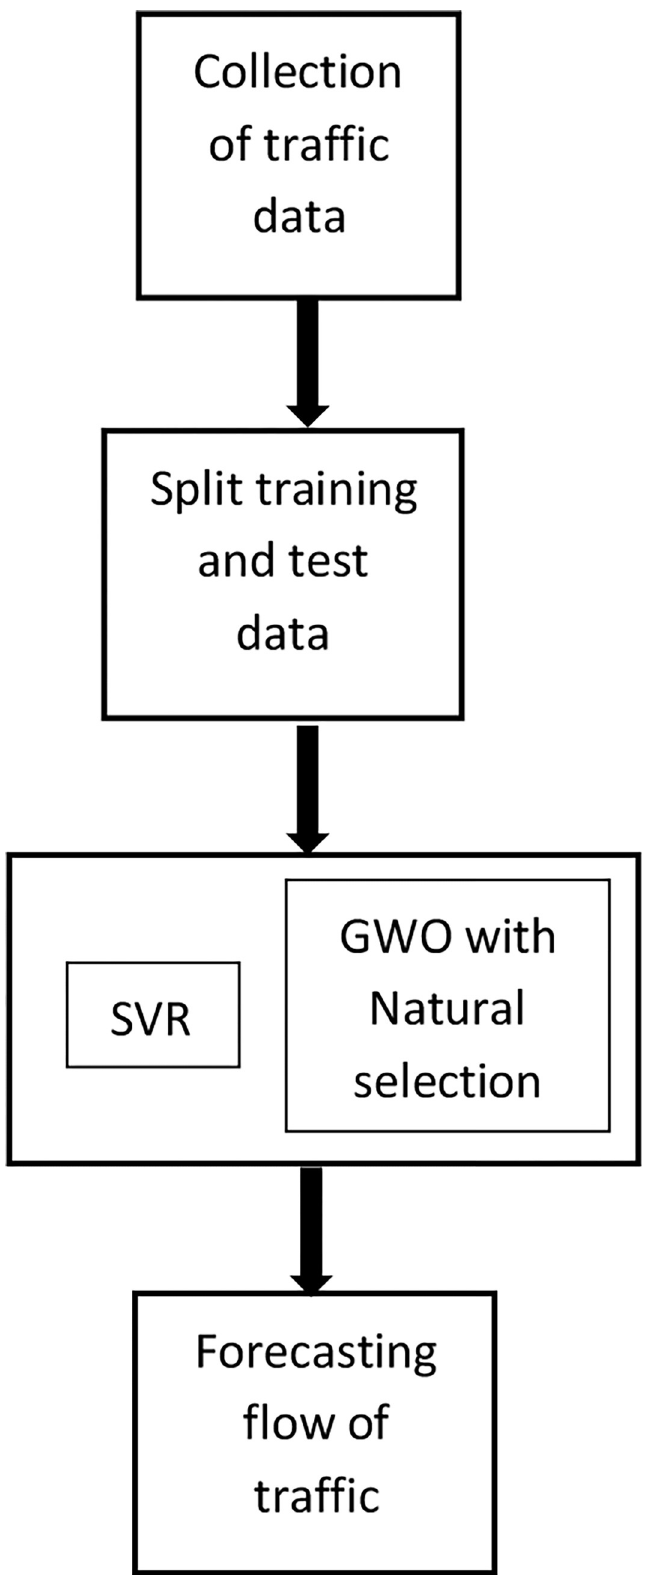
Fig 3. Hybrid SVR-xGWO-BES for traffic forecasting.